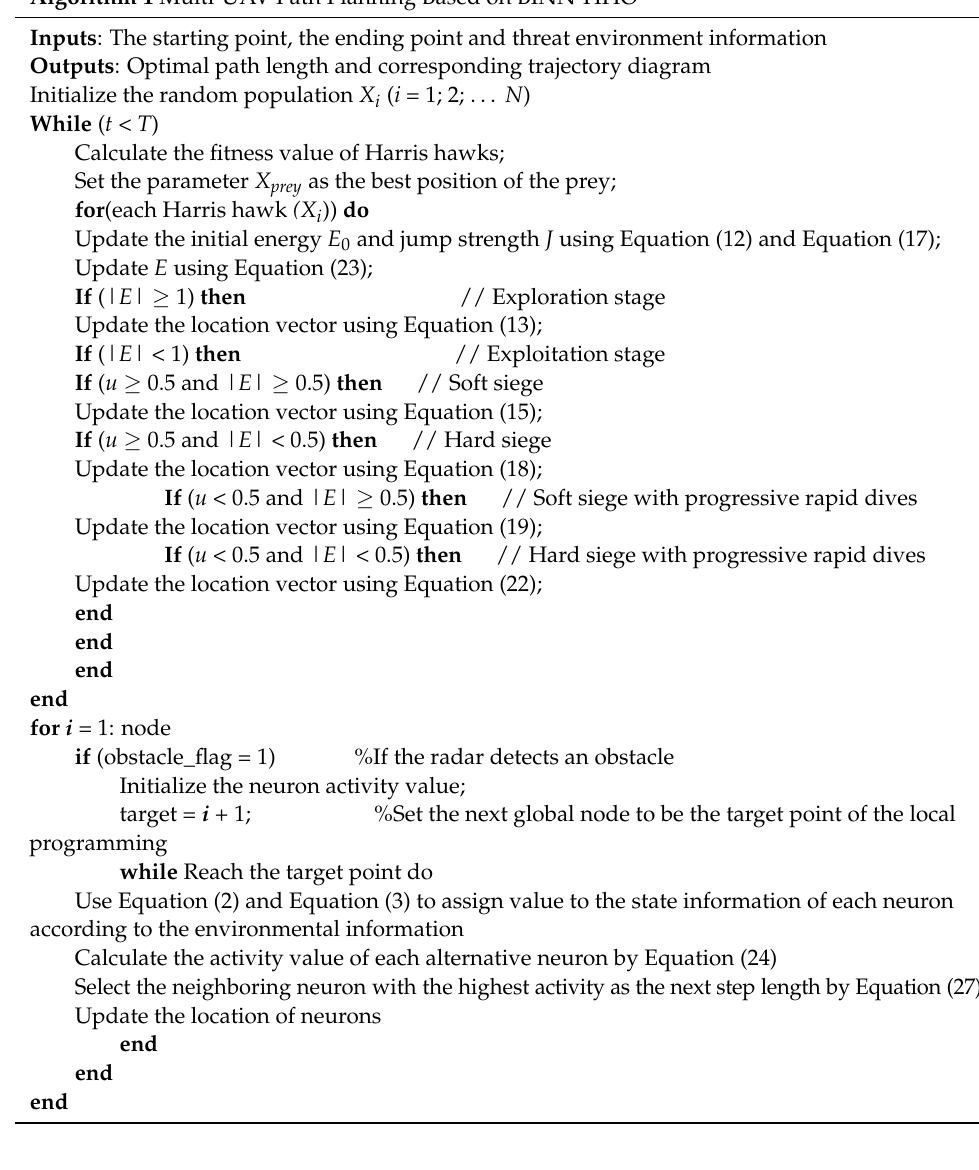
Algorithm 1 Multi-UAV Path Planning Based on